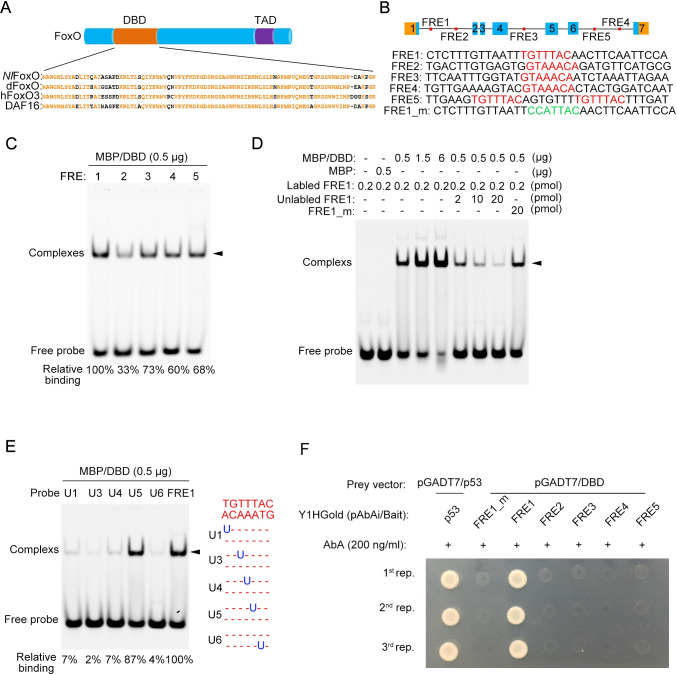
Electrophoretic mobility shift assay (EMSA).(A) Schematic depiction of the NlFoxO domains and sequence alignment. NlFoxO contains a DNA binding domain (DBD) and a transactivation domain (TAD). The NlFoxO DBD was aligned with its orthologs from D. melanogaster (dFoxO), C. elegans (DAF16), and H. sapiens (hFoxO3). (B) Schematic diagram of the distribution of the FoxO recognition element (FRE) in Nlvg. The FoxO consensus binding site (TGTTTAC or its complementary sequence, in red) and its flanking sequences are indicated in FRE1–5. The FRE1_m was generated by randomly mutating the FoxO consensus binding site (TGTTTAC) of FRE1 to ‘CCATTAC’ (in green). (C) EMSA of MBP/DBD binding to Alexa Fluor 680-labeled FRE1-5. (D) EMSA of the MBP/DBD binding to Alexa fluor 680-labeled FRE1, unlabeled FRE1, and mutant FRE1 (FRE1_m). (E) EMAS of the MBP/DBD binding to Alexa fluor 680-labeled FRE1 containing substitutions within the FoxO consensus sequences. The protein-DNA complex is indicated by arrowheads. The relative binding affinity is shown at the bottom. (F) Binding of MBP/DBD to FRE1–5 in a yeast one-hybrid assay. Vectors containing p53 and mutant FRE1 (FRE1_m) served as positive and negative controls, respectively. AbA, Aureobasidin A antibiotic. Experiments were performed three times with similar results (1st-, 2nd-, and 3rd-rep.).